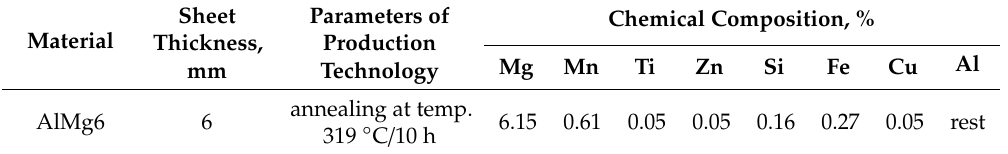
Table 1. Chemical composition and heat treatment parameters of the AlMg6 alloy sheet. Sheet Parameters of Material Thickness, Production mm